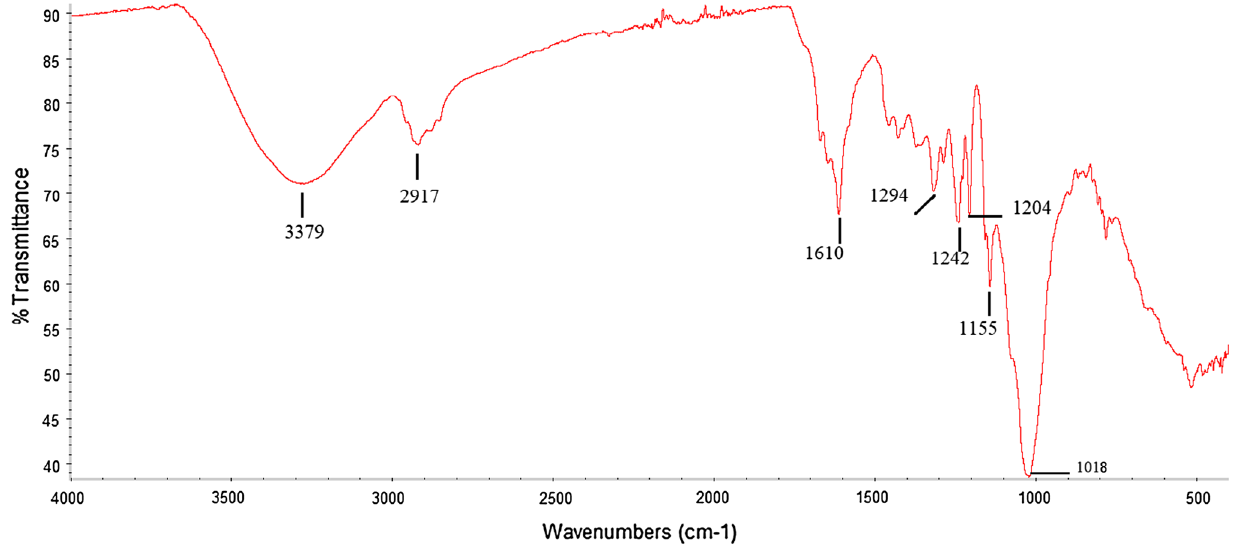
Fig. 1 FT-IR spectrum of the